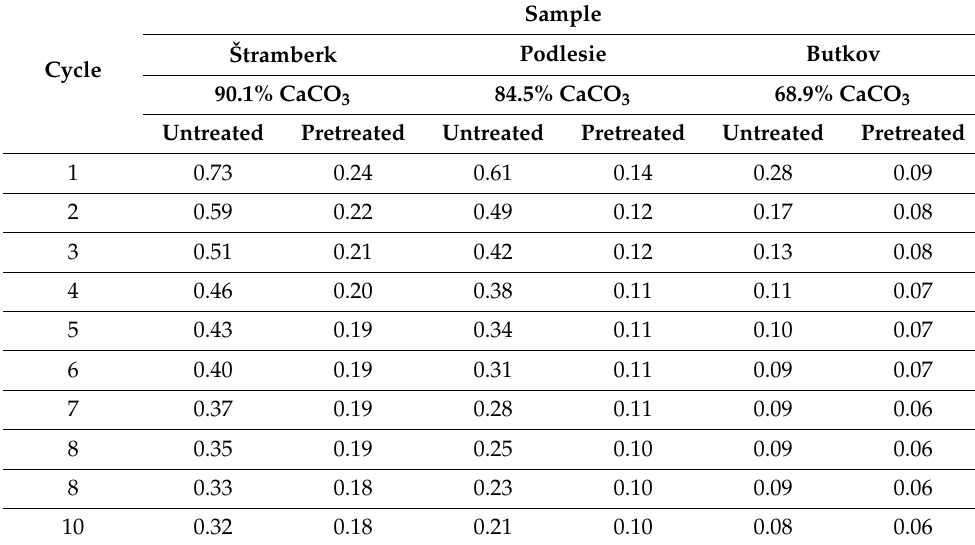
Table 2. Conversion in raw and pretreated limestones.